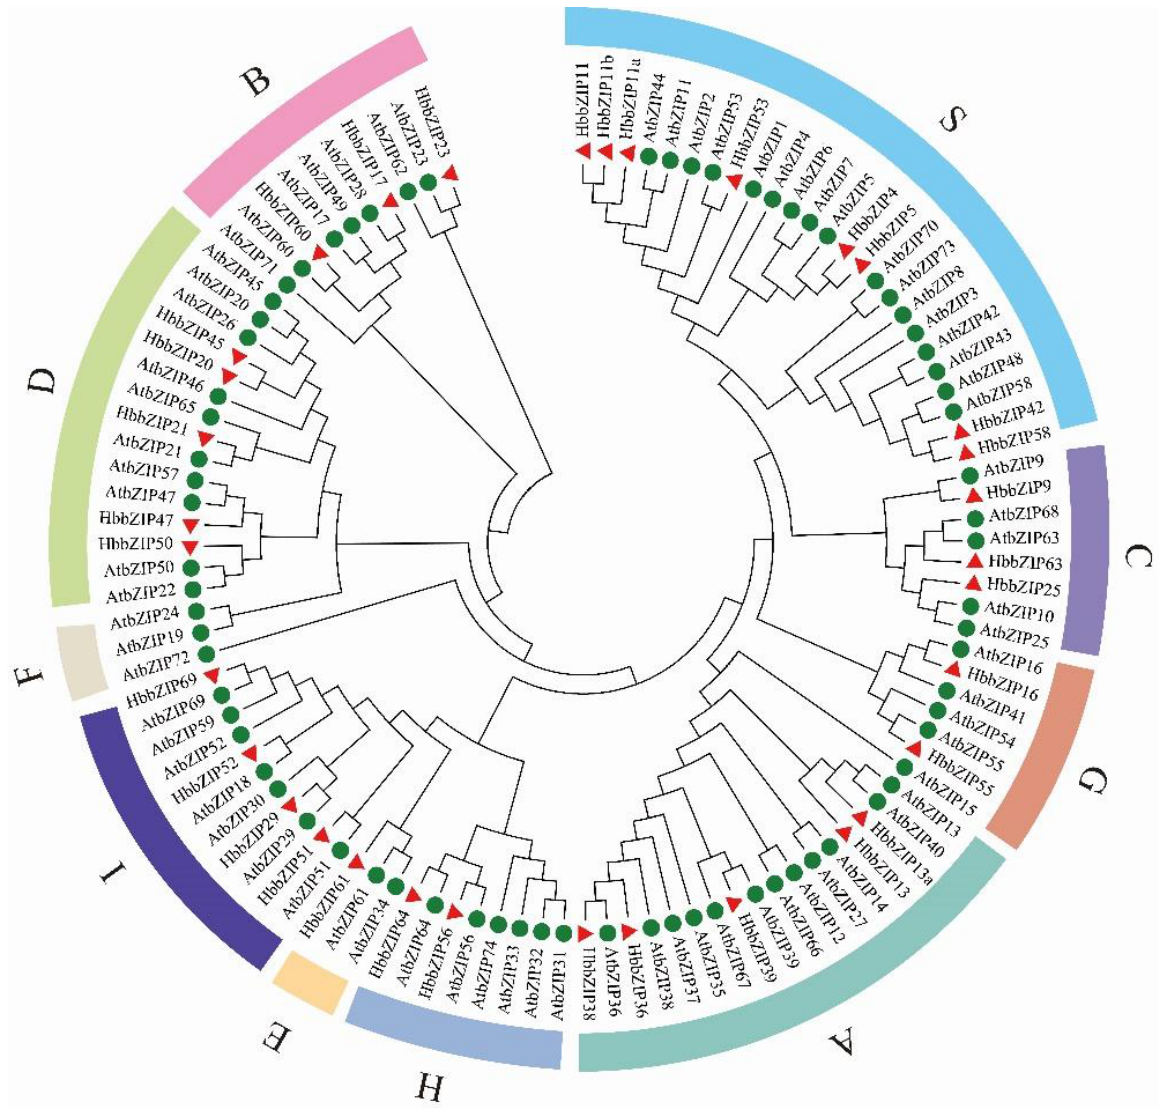
Figure 1. Phylogenetic tree of bZIP family genes among 33 HbbZIPs and 74 AtbbZIPs